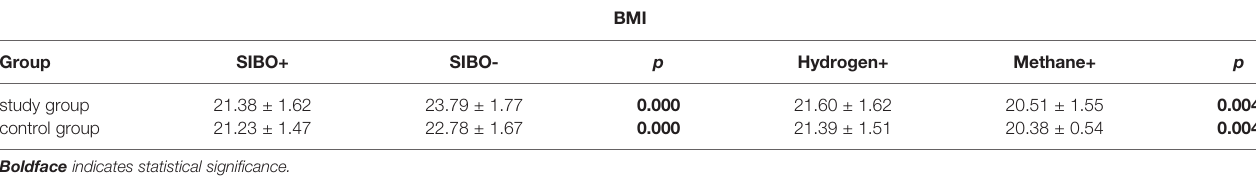
Boldface indicates statistical signi fi cance. TABLE 5 | The rate of TPOAb-positive and negative, FT4 and TSH levels in pregnant women with subclinical hypothyroidism (study group) and the control group (control group), respectively. SIBO+ p TPOAb+